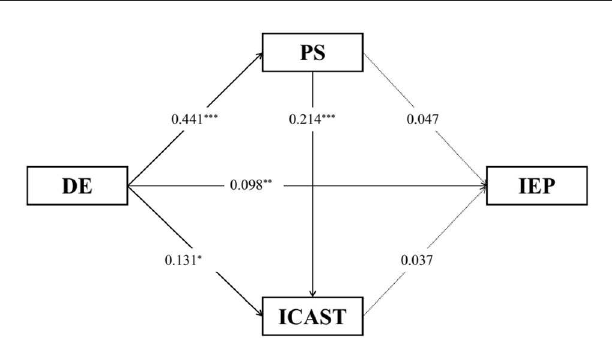
FIGURE2 The mediation model between parental depression and children’s internalizing and externalizing problems through parenting stress and child